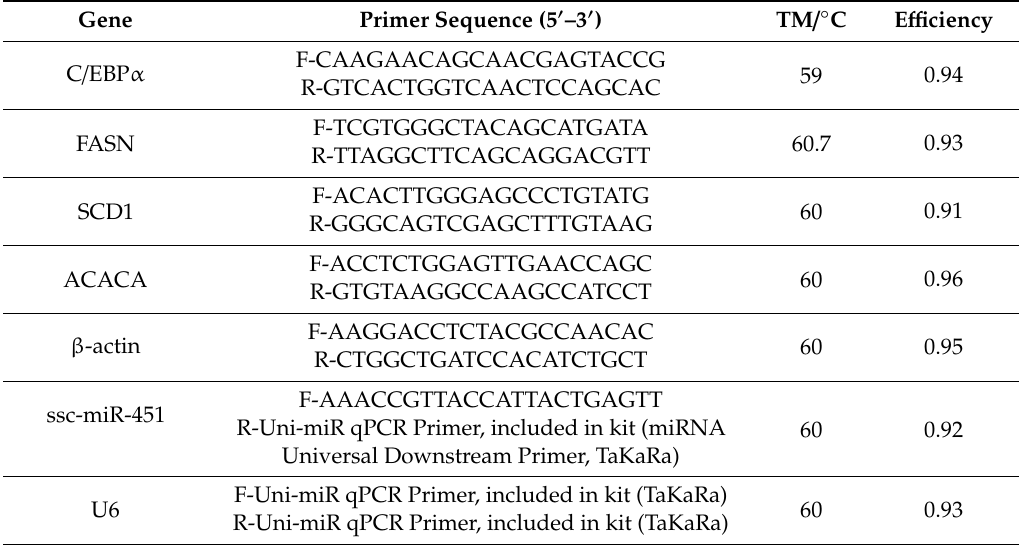
Table 1. The primer sequences used for qRT-PCR (F: Forward, R: Reverse). Gene Primer Sequence (5 (cid:48) –3 (cid:48)